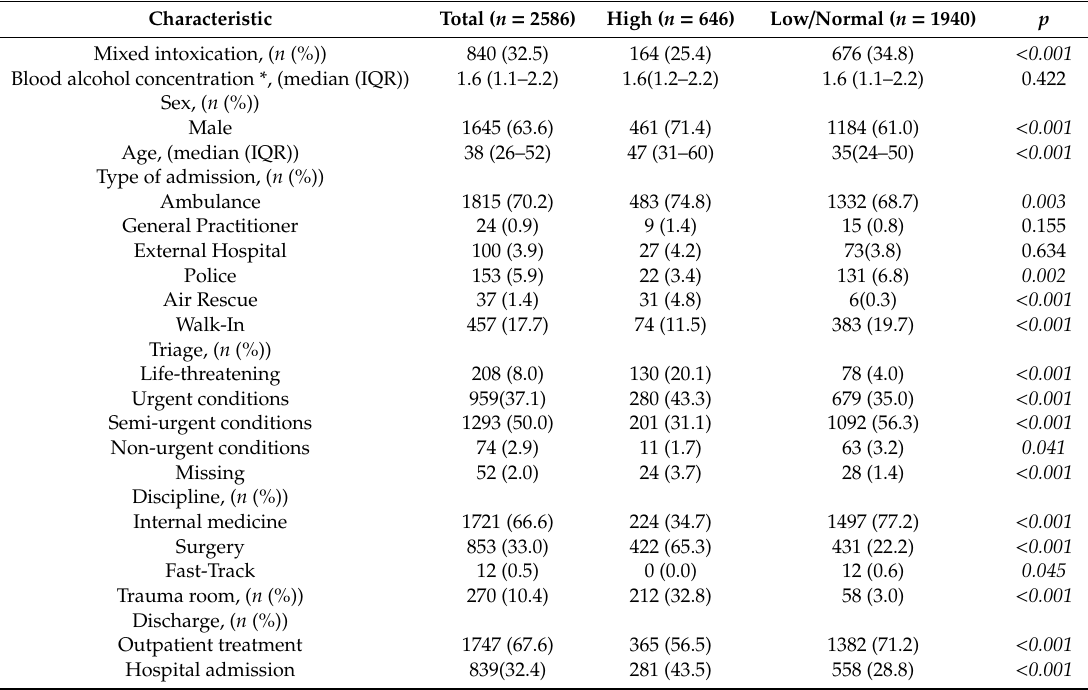
Table 1. Consultation characteristics of the group of patients ( n =